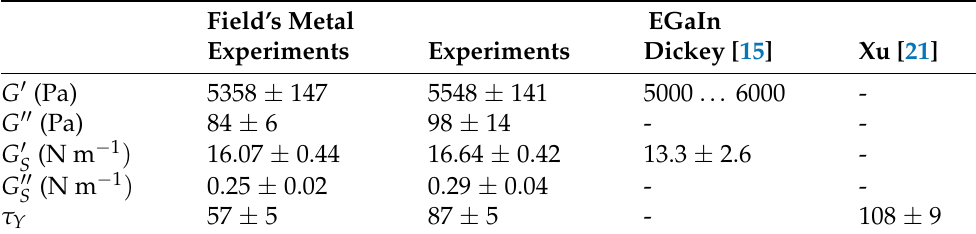
Table 4. Rheological parameters obtained in this study and previous works.